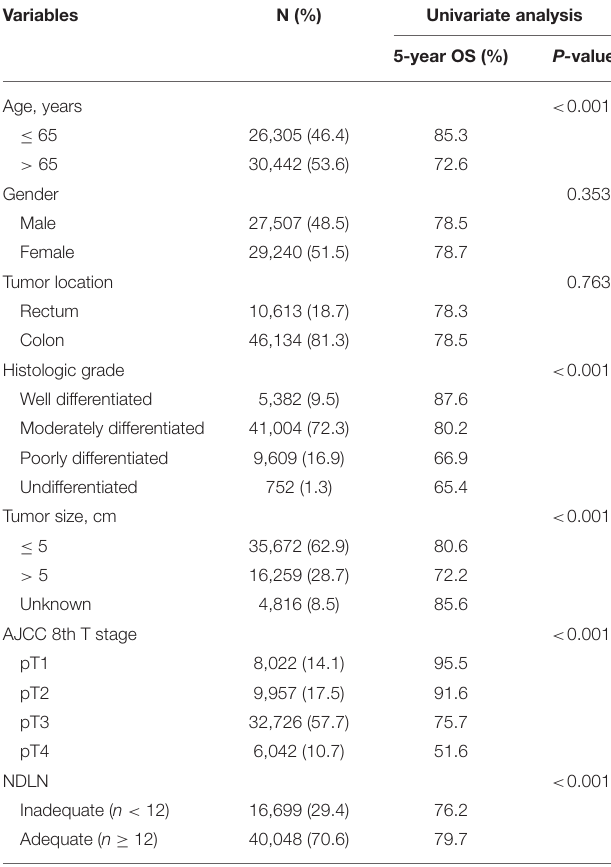
TABLE 2 | Clinical and histopathological characteristics for the entire population.